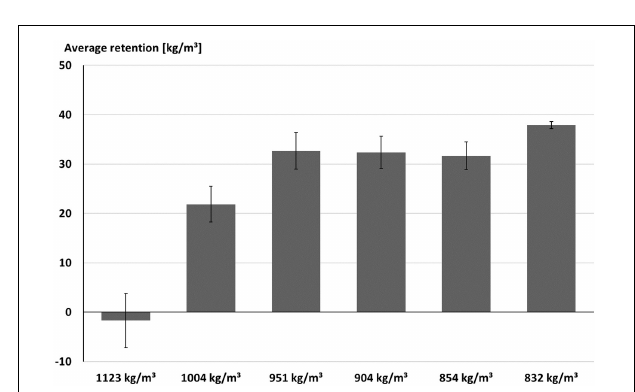
FIGURE 9 | Penetration depth of an alternative oily preservative in mm in specimens with incising.